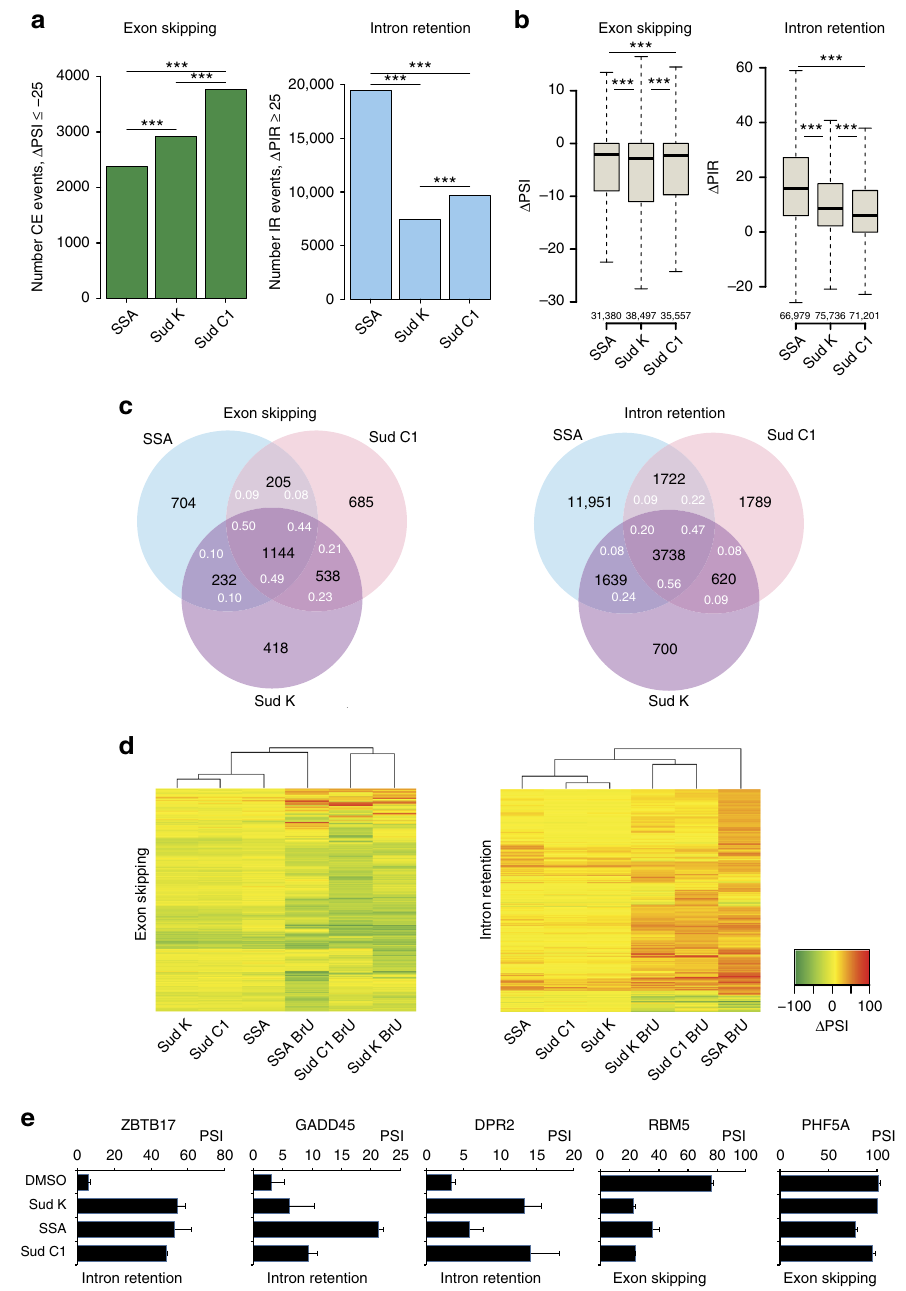
Fig. 6 Distinct pro fi les of AS changes induced by SSA and Sud C1 or Sud K. a Number of cassette exons and retained introns affected by each of the three drugs in BrU RNA. *; **; ***: χ 2 -test P values < 0.01, 0.001, and 0.0001 by comparing regulated events to all detected cassette exons (39,851) and retained introns (76,961), respectively. b Distribution of AS changes for cassette exons and retained introns induced by each of the three drugs in BrU RNA. *; **; ***: Mann – Whitney U -test (two-sided) P value < 0.01, 0.001, and 0.0001, respectively. Outliers were discarded, boxes indicate interquartile range (IQR), whiskers extend to 1.5 times IQR. Black lines indicate median values. c Overlaps between sets of cassette exons and retained introns affected by each of the three drugs, detected in BrU RNA data. Numbers in white indicate the percentage of events in common between the closest drug and the drug(s) in the corresponding overlap section. d Clustering analysis of changes in cassette exon skipping or intron retention. Heatmaps represent Δ PSI values of cassette exons upon parallel treatment with the drugs (5 nM SSA, 10 µ M Sud C1, and 2 µ M Sud K) for 3 h as detected in total or BrU-pulsed RNAs by RNA-seq using VAST-TOOLS (Methods). Only cassette exons or introns with | Δ PSI | or | Δ PIR | ≥ 25 were considered. e Examples of validation of differences in AS changes between drugs, predicted by the RNA-seq analyses in d . The names of the genes, type of AS, and PSI values under the different conditions are indicated. Treatments were performed in duplicates (5 nM SSA, 10 µ M Sud C1, and 2 µ M Sud K). Error bars correspond to